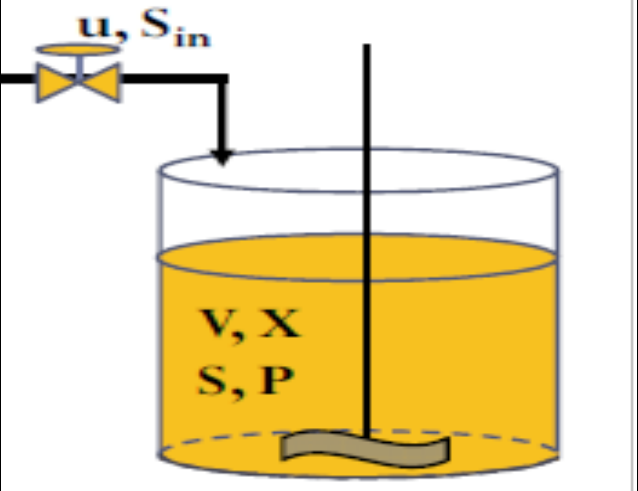
Figure 13: Diagram of a Batch Bioreactor.